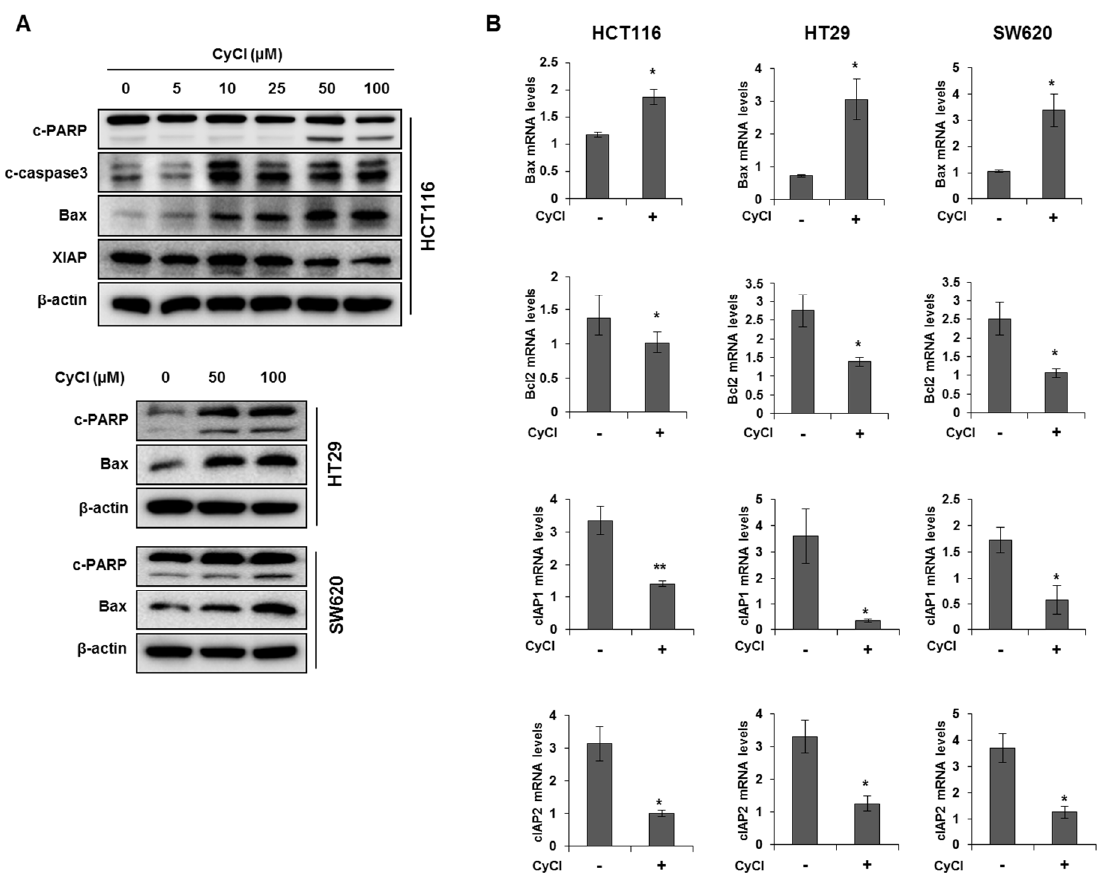
Figure 3. CyCl induces apoptosis in colon cancer cell lines. ( A ) HCT116, HT29, and SW620 cells were treated with indicated concentrations of CyCl and incubated for 24 h. Protein extracts were separated by SDS-PAGE, and Western blot analysis was conducted for the levels of B-cell lymphoma 2-associated X protein (Bax), X-linked inhibitor of apoptosis protein (XIAP), cleaved caspase-3, and poly-ADP-ribose polymerase (PARP) cleavage. ( B ) Colon cancer cells were treated with 50 µM of CyCl and incubated for 24 h. RNA was extracted from the cells and mRNA expression of Bax, B-cell lymphoma 2 (Bcl2), cellular inhibitor of apoptosis protein (cIAP)1, and cIAP2 was measured by qRT-PCR analysis. All experiments were carried out in triplicate. * p < 0.05 and ** p < 0.01, significantly different compared with control.